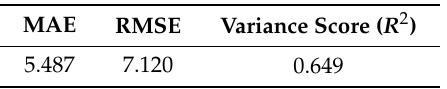
Table 4. Prediction result of sap amount based on Liner